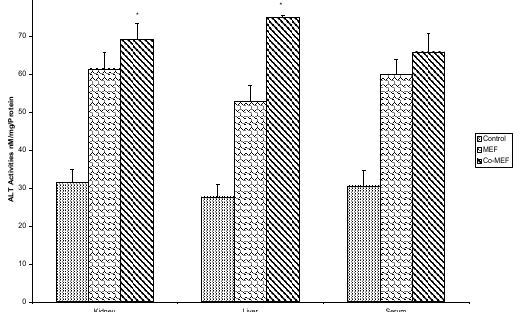
Figure 4. Effect of administration of ligands and metal complexes on the activities of aspartate amino transferase (ALT) of rat serum, kidney and liver. * Significantly different from the control (p<0.05).